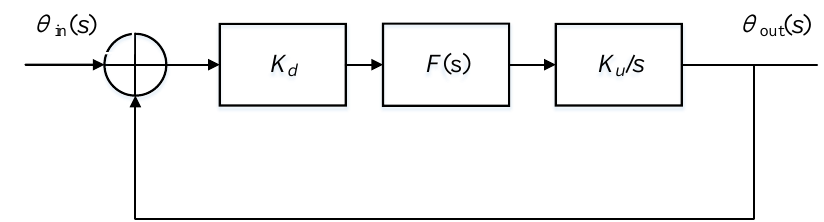
Figure 4. Principle of phase locked loop.